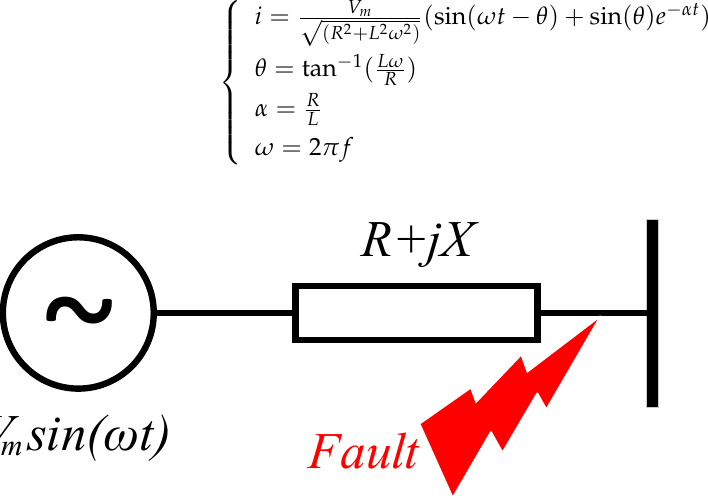
Figure 1. Fault current of a distribution system.